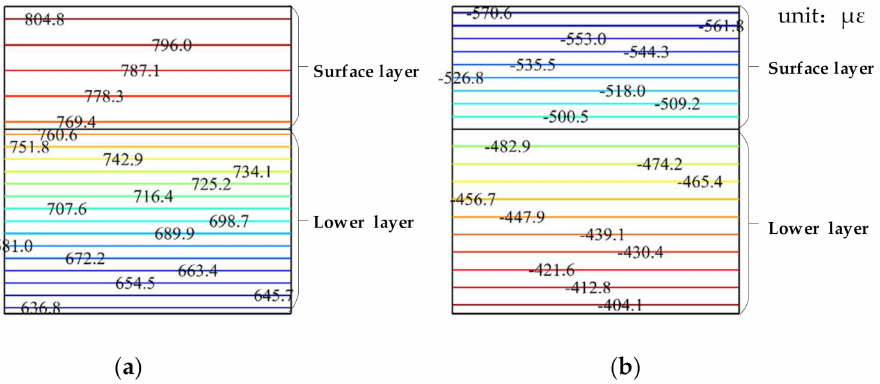
Figure 6. Cloud chart of horizontal strain variation with the pavement depth, where ( a ) is the case of water phase transition and ( b ) is the case of nonwater phase